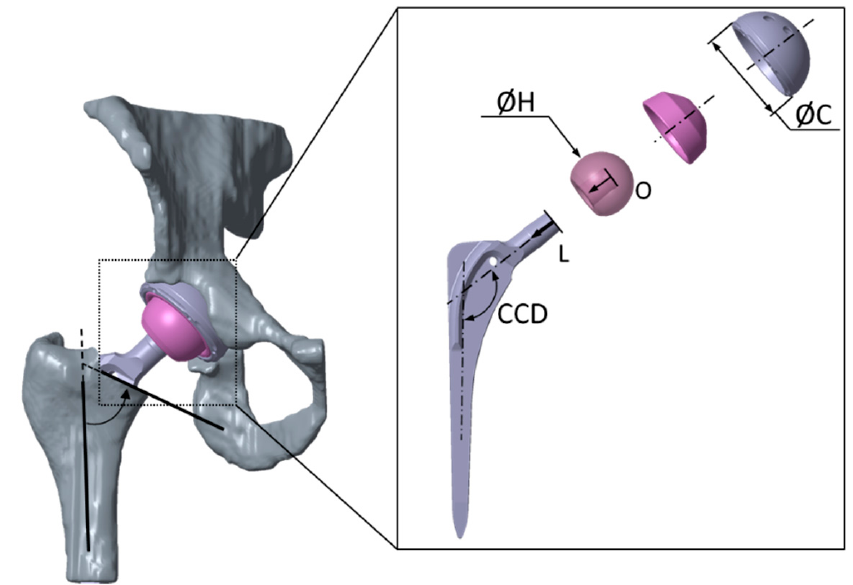
Figure 2. Virtually implanted total hip replacement (Bicontact ® hip stem and Plasmacup ® SC acetabular cup with a ceramic-on-ceramic bearing). The virtual implantation was carried out by an experienced orthopedic surgeon. Implant design parameters are subject to variation for the implant shaft (neck-to-shaft angle CCD, neck length L, head offset O, neck length L, and head diameter H) as well as for the acetabular cup (diameter C) of the analyzed total hip replacement.